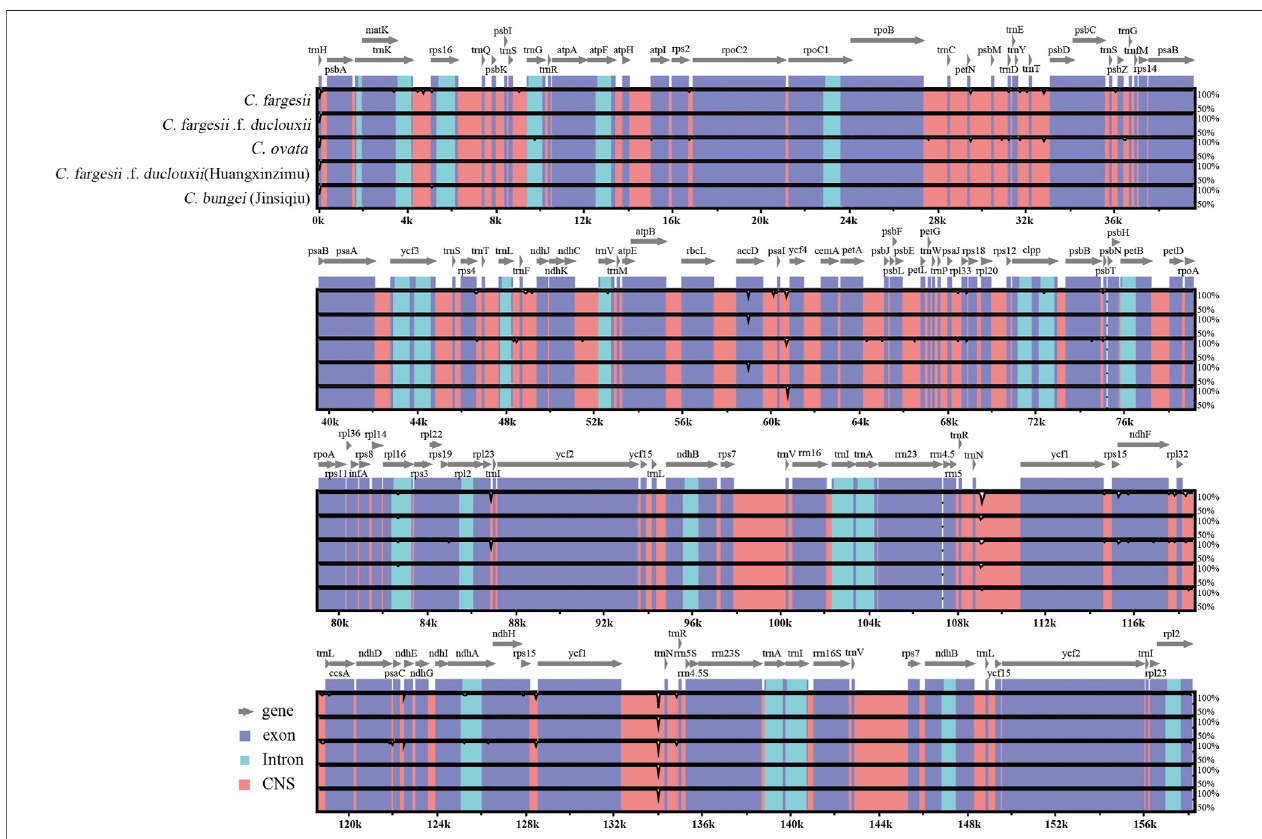
FIGURE4| Visualizationofthechloroplastgenomealignmentsofsixtaxawithinthegenus Catalpa using C.bungei asareferenceinmVISTA.The x -axisrepresents thepositioninthechloroplastgenome.Thesequencesimilarityofthealignedregionsisshownashorizontalbarsindicatingtheaveragepercentidentitywithin50 – 100%.